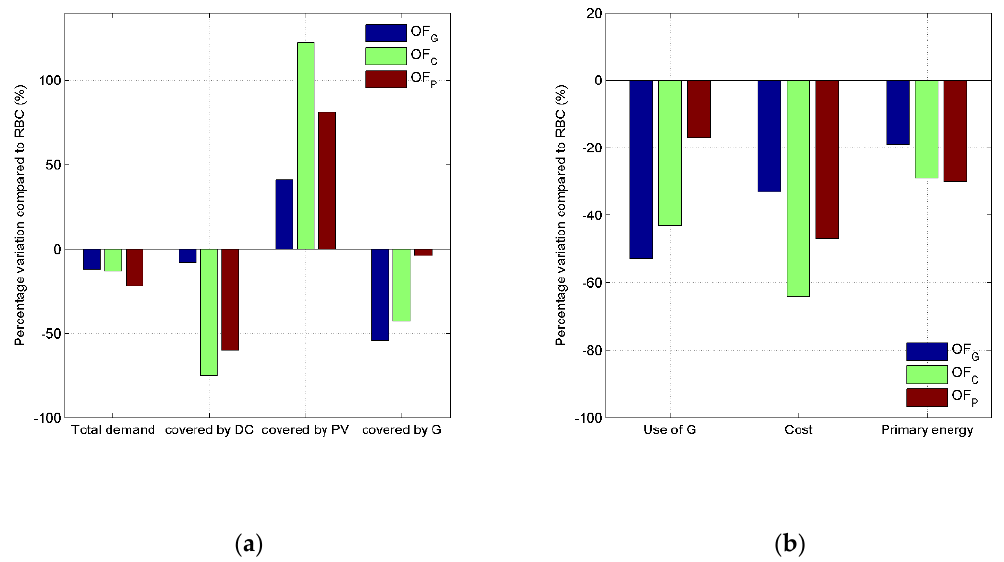
Figure 20. Comparisons among OF G , OF C and OF P in the MPC for the whole cooling season ( PH = 18 h) in terms of percentage variation, compared to RBC, of: ( a ) thermal demand composition; ( b ) seasonal values of the three optimized quantities percentage reduction.